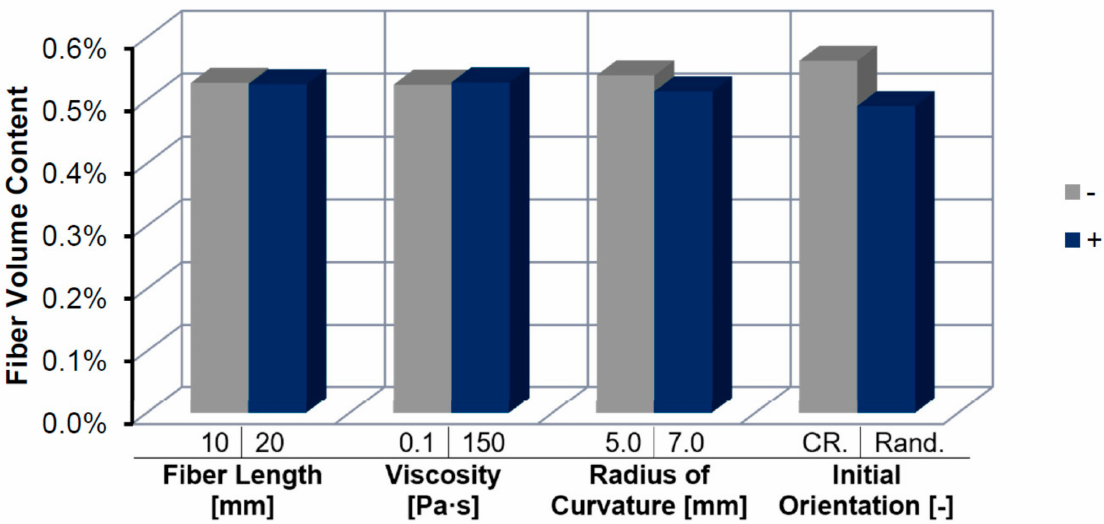
Figure 10. Average effect on volume fraction in bottom section of rib.